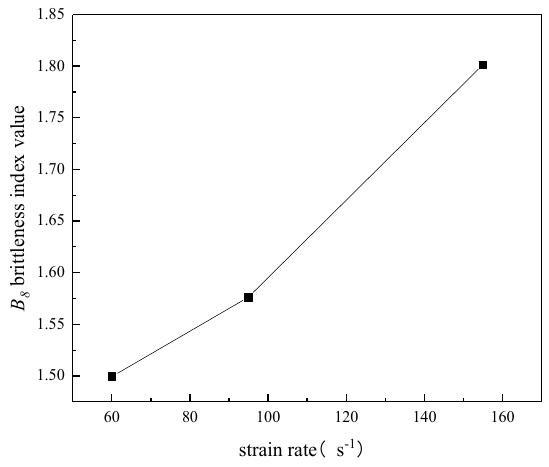
Figure 9. Changes in B 8 at different strain rates.